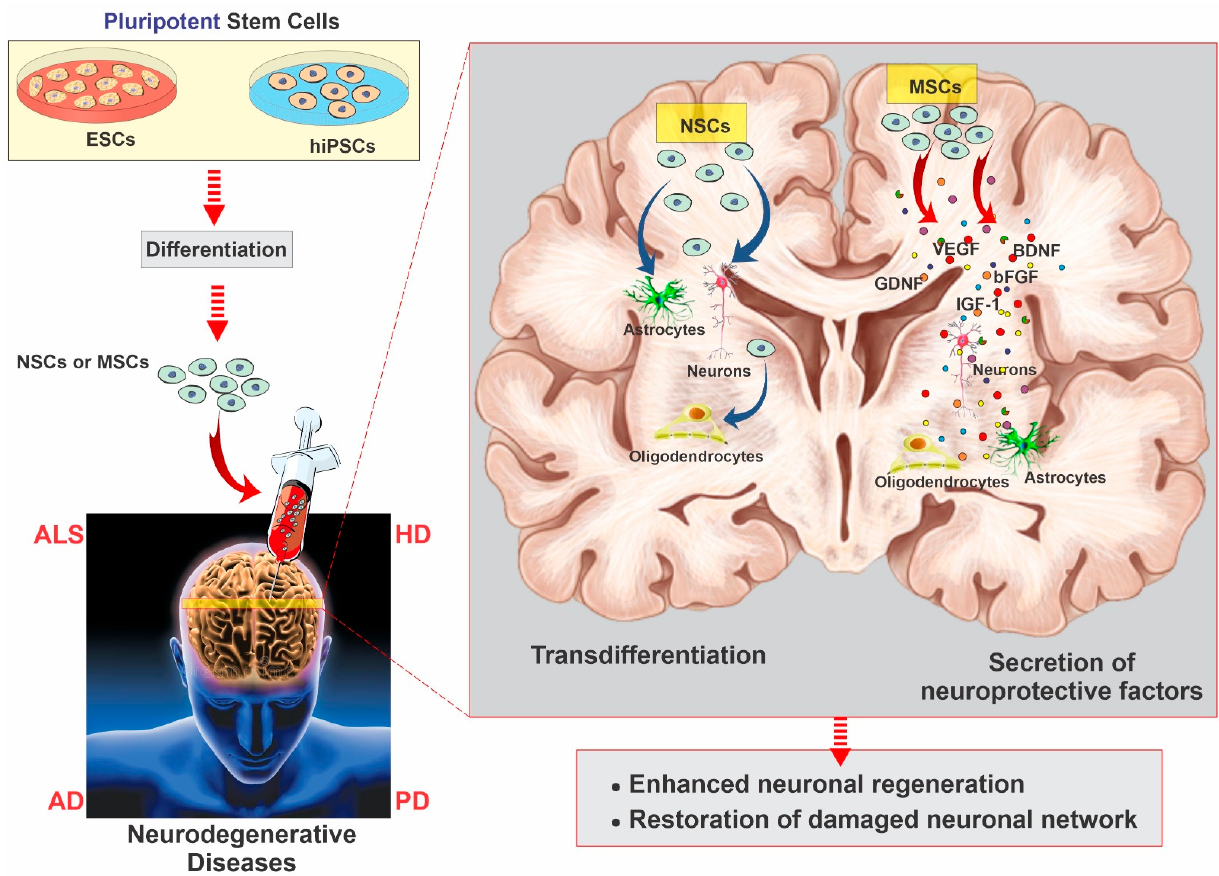
Figure 3. Neurodegenerative disease modeling of hiPSCs and ESCs. These cells can be differentiated into neuronal pro- genitor (NPCs) and MSCs, from which brain cells, such as oligodendrocytes, astrocytes, and different neuronal and glial lineages, can be generated. Note also that the trophic action of MSCs, including the secretion of growth and neurotrophic factors, can act as a coadjuvant to nervous tissue regeneration by promoting angiogenesis, neurogenesis, and immuno- modulation. AD: Alzheimer’s disease, ALS: amyotrophic lateral sclerosis, HD: Huntington’s disease, PD: Parkinson’s dis- ease; BDNF: brain-derived neurotrophic factor, bFGF: basic fibroblast growth factor, IGF-1: insulin-like growth factor 1, GDNF: glial-derived neurotrophic factor, VEGF: vascular endothelial growth factor.